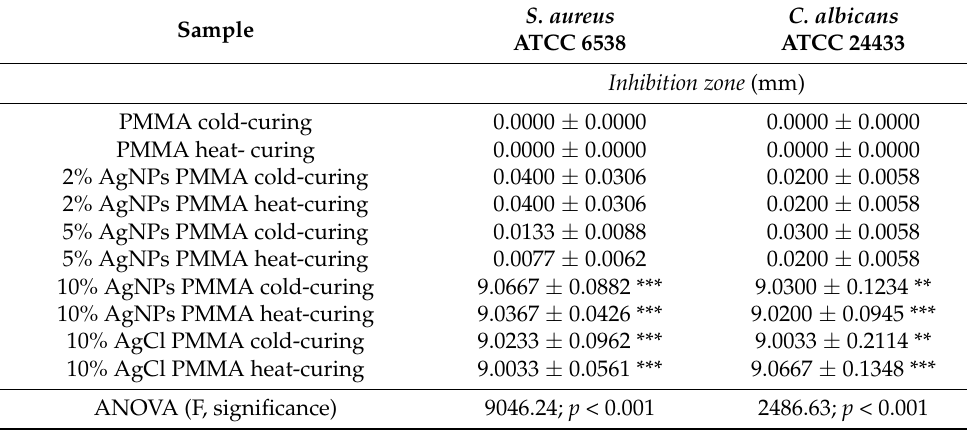
Figure 5. ( a ) SEM image of cold-curing PMMA with 10.0 wt% of AgNPs (1500 × , bar 10 µ m). ( b ) SEM image of cold-curing PMMA with 10.0 wt% of AgCl (500 × , bar 10 µ m). Table 1. Antimicrobial activity of samples against S. aureues and C. albicans strains tested by the disk-diffusion antibiotic sensitivity method. Zones of inhibition are expressed in mm. The results are averages ± S.E. ( n = 3).